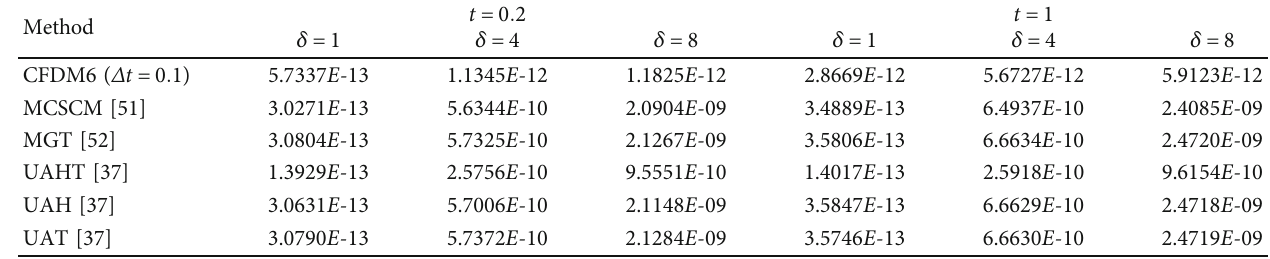
β = 0 : 1 , γ = 0 : 001 , η = 0 : 0001 , h = 0 : 1 , and Δ t = 0 : 001 for di ff erent values of δ . Table 8: Comparison of L ∞ error norm of Example 5 with Method